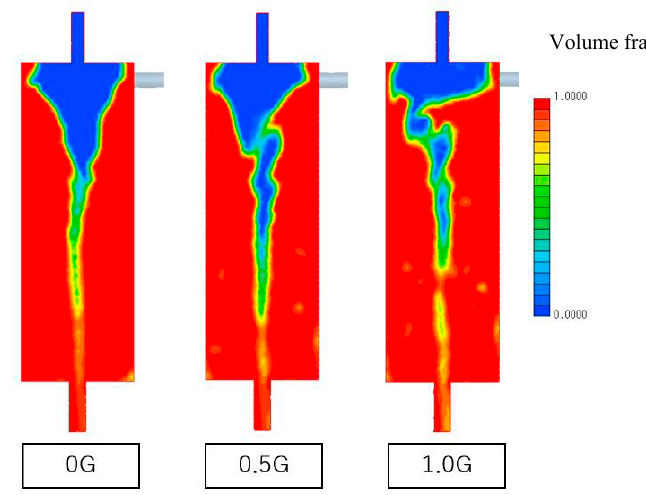
Figure 13. CAE analysis results of volume fraction under lateral acceleration .